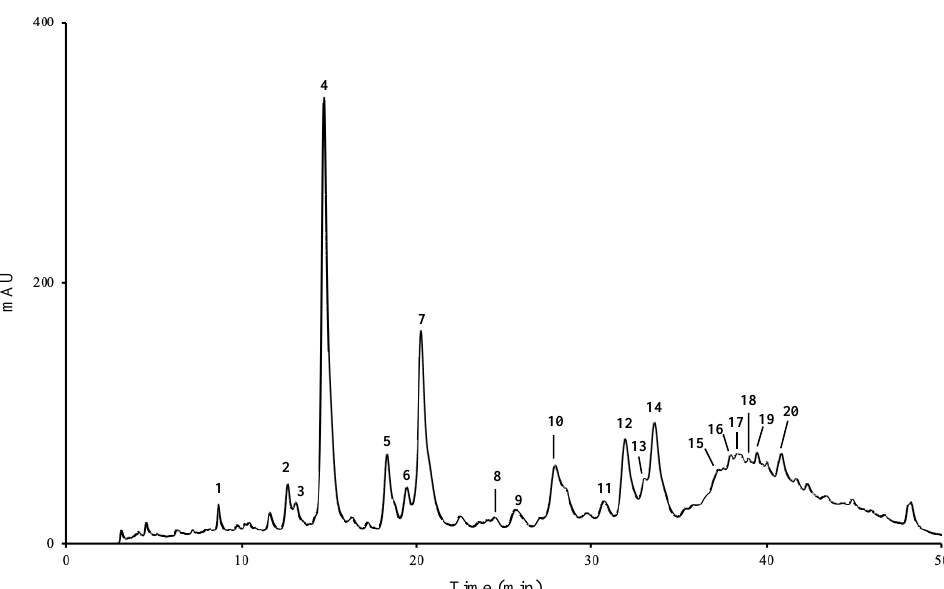
Figure 1. HPLC-DAD chromatogram of camel grass aqueous extract, recorded at 320 nm. 1 : 3- O - caffeoylquinic acid; 2 : 4- O -caffeoylquinic acid; 4 : chlorogenic acid; 7 : p -coumaric acid; 9 : ferulic acid; 12 : isoorientin; 13 : luteolin glycoside; 14 : luteolin- 3′ ,7-di- O -glucoside; 3 , 5 , 6 and 8 : caffeic acid derivatives; 10 , 11 , 15 – 20 : apigenin glycosides.